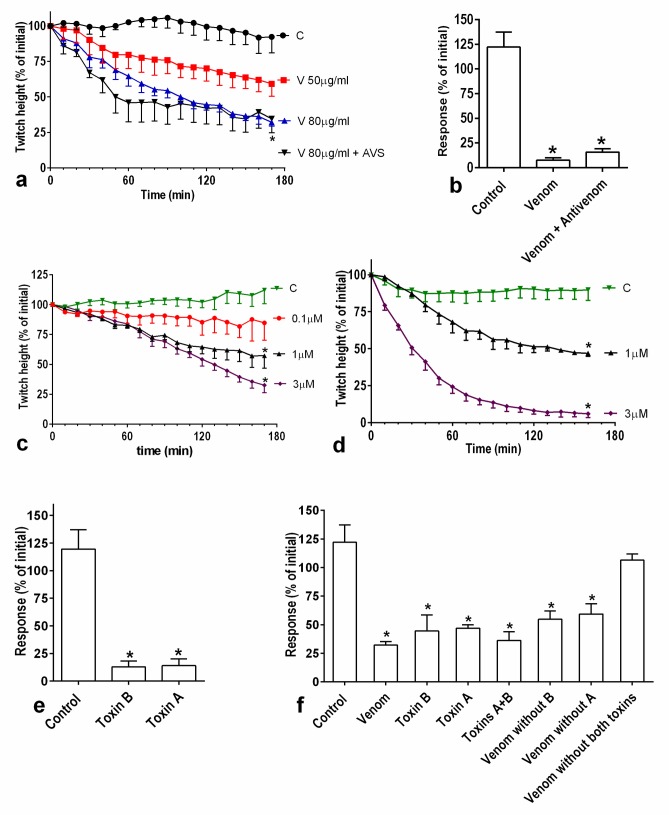
In-vitro myotoxicity of whole venom (Venom) of Sri Lankan Russell’s viper, U1-viperitoxin-Dr1a (Toxin A) and U1-viperitoxin-Dr1b (Toxin B) compared to controls: (a), Concentration-dependent inhibition of direct twitches in chick biventer nerve-muscle preparation by whole venom. (* the 80μg/ml venom group is significantly different from 50 μg/ml group as well as the control group at 170 min; p<0.05: One-way ANOVA followed by Bonferroni’s post-hoc test, n = 4.). (b), Effect of 80μg/ml venom alone and in the presence of antivenom on the response of the muscle to 40mM KCl. (* significantly different compared to the response to KCl obtained prior to the addition of venom; p<0.05: paired t-test) (c), Concentration-dependent inhibition of the direct twitches in chick biventer nerve-muscle preparation by U1-viperitoxin-Dr1b. *(twitch height significantly lower than the control group: p<0.05, one-way ANOVA followed by Bonferroni’s post-hoc test; n = 3–5); (d), Concentration-dependent inhibition of the direct twitches in chick biventer nerve-muscle preparation by U1-viperitoxin-Dr1a. (* twitch height significantly lower than the control group: p<0.05, one-way ANOVA followed by Bonferroni’s post-hoc test; n = 3–5); (e), Effect of 3 μM U1-viperitoxin-Dr1a (B) and U1-viperitoxin-Dr1b (M) towards the response of the muscle for 40 mMKCl. (* the KCl response of the venom with and without antivenom, at 170min were significantly reduced compared to the initial responses; p<0.05: paired t-test); (f), Effect of 50μg/ml whole venom versus U1-viperitoxin-Dr1a, U1-viperitoxin-Dr1b, venom without U1-viperitoxin-Dr1a, venom without U1-viperitoxin-Dr1b, both toxins together, venom without both toxins of a same amount of venom in 5ml organ bath towards the response of the muscle for 40 mMKCl. * (* the KCl response is significantly lower compared to the control group at 170 min; p<0.05: one-way ANOVA followed by Bonferroni’s post-hoc test; n = 3–5).